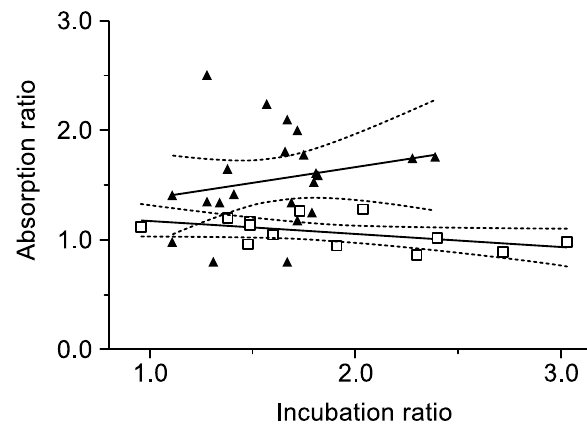
Figure 5. Regression lines of incubation ratios against absorp- tion ratios. Regression lines are plotted for the protected (n=13; open squares) and infected (n=22; triangles) immunized rhesus macaques. Strictly speaking, as neither the incubation ratio nor the absorption ratio can be considered the independent variable and neither has a fixed value, a regression analysis is not legitimate. None the less, for the reader’s convenience, we present linear regression lines in the form of y=mx + c: Protected macaques: m= 2 0.119 6 0.061; c=1.293 6 0.121; r 2 = 0.2557; p = 0.0779. Infected macaques: m = 0.287 6 0.290; c=1.090 6 0.477; r 2 =0.04685; p=0.3333. The gradients of the lines are not statistically significantly different (p=0.1785). in contrast, the intercepts are highly significantly different